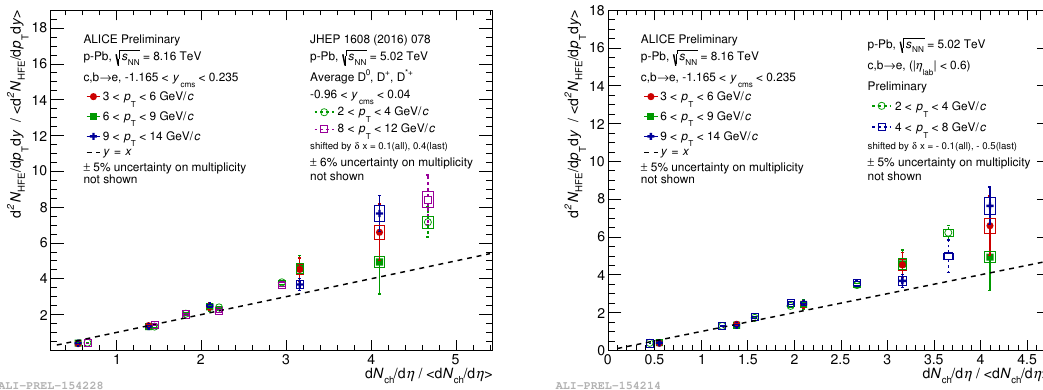
Figure 6. Relative yield of HFE as a function of the relative charged-particle multiplicity in p–Pb √ s NN = 8.16 TeV compared with the average yield of D mesons in p–Pb collisions at collisions at √ s NN = 5.02 TeV ( left ) and with the relative yield of HFE in p–Pb collisions at